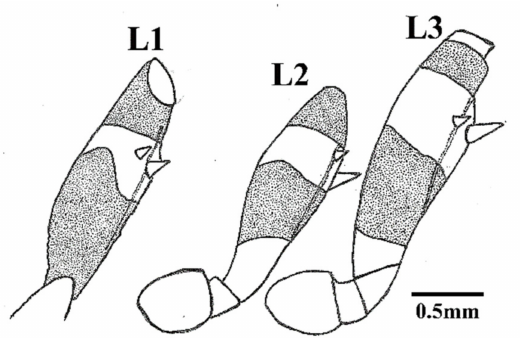
Figure 6. Schematic outline of the legs of Belminus santosmalletae sp. n., showing the denticles ( L1 —fore; L2 —middle; L3 —hind leg).